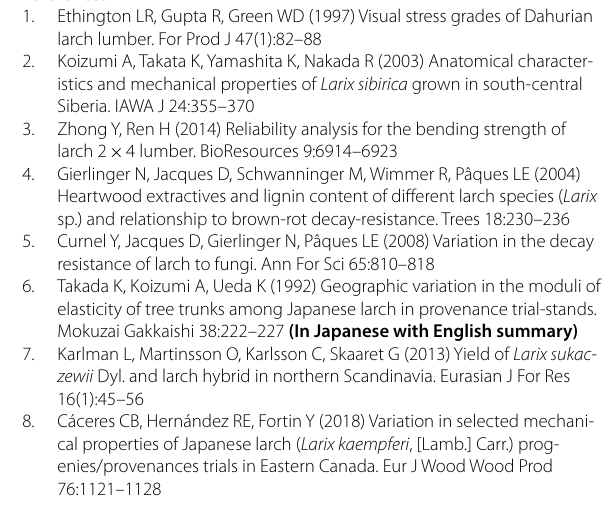
Standard deviation